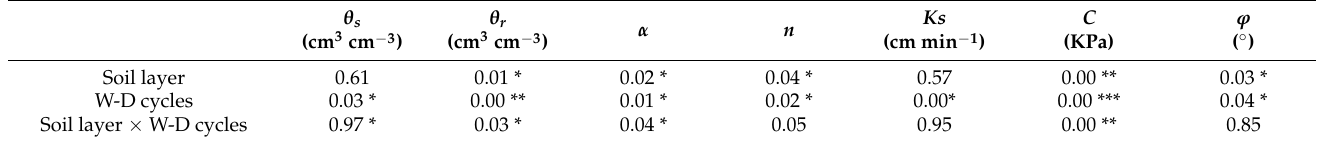
Table 5. p values from the general linear model (GLM) to test the influence of soil layer and W-D cycles and their interaction on the soil